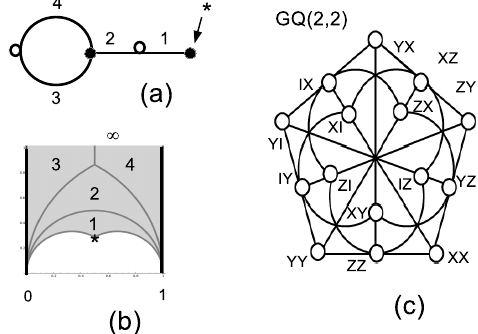
Figure 3. Representation of A 4 ∼ = Γ 0 ( 3 ) as a map ( a ) and as the tiling of the fundamental domain (the two thick vertical lines have to identified) ( b ). The character * denotes the unique elliptic point (of order 3). The organization of triple products of projectors leads to the generalized quadrangle GQ ( 2,2 ) pictured in panel ( c ).